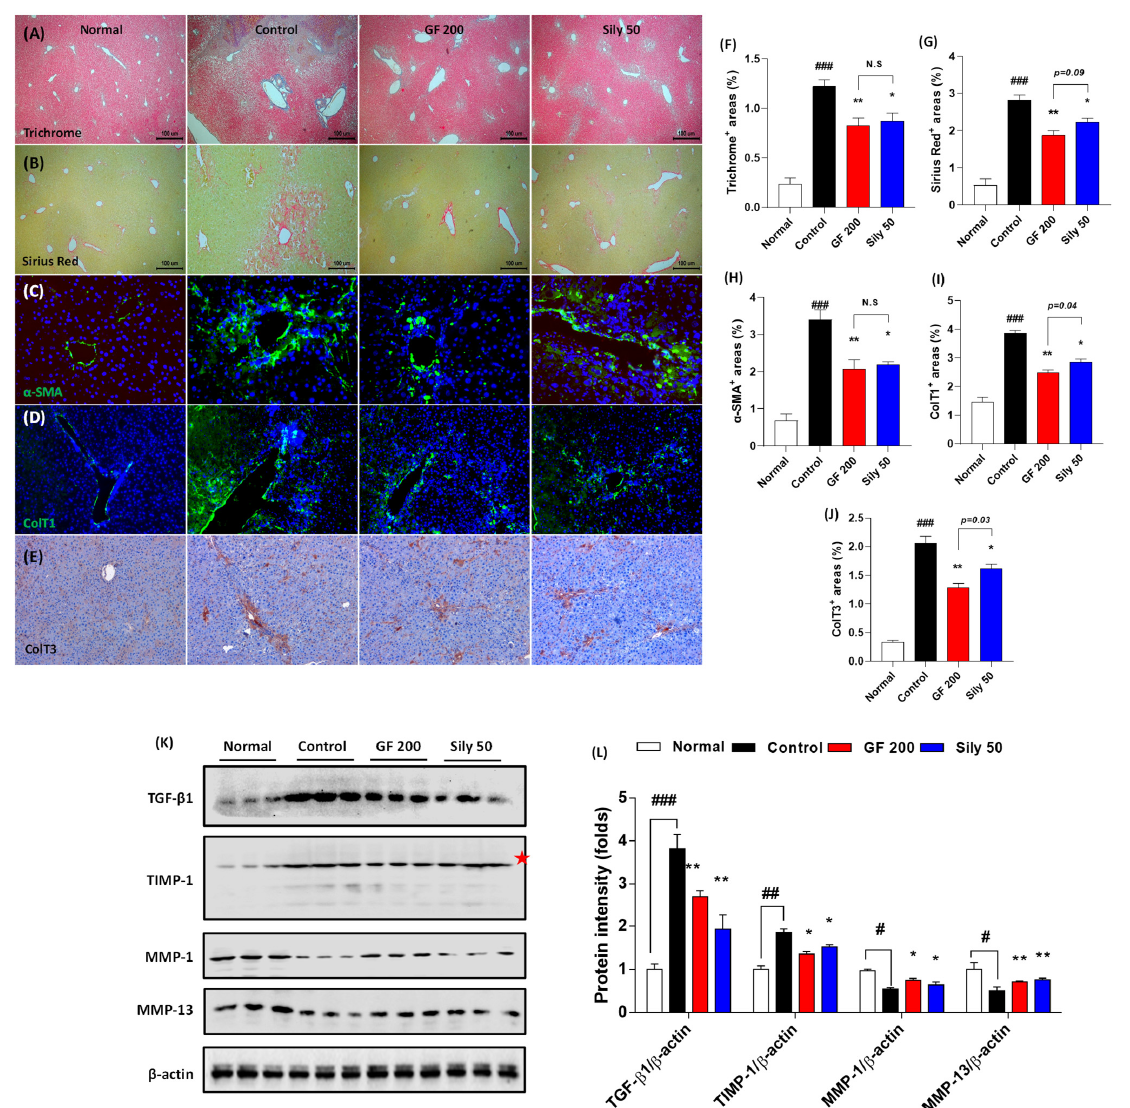
Figure 4. GF attenuates liver fibrosis by degradations of ECMs in tissue. ( A ) Masson’s trichrome staining, ( B ) Sirius Red staining, ( C ) IF analysis against α -SMA, ( D ) Collagen type 1, and ( E ) IHC against Collagen type 3. ( F – J ) Quantification analyses for Masson’s trichrome staining, Sirius Red staining, IF analysis against α -SMA, Collagen type 1, and IHC against Collagen type 3. ( K ) Western blot analysis of ECM proteins TGF- β 1, TIMP-1, MMP-1, and MMP-13 and ( L ) protein intensity. Data were expressed mean ± SEM ( n = 4 for each group in staining images; n = 3 for each group for Western blot analysis). N.S, not significant, # p < 0.05, ## p < 0.01, and ### p < 0.001 for Normal vs. Control; * p < 0.05 and ** p < 0.01 for Control vs. GF 200 or Sily 50. Masson’s trichrome, Sirius Red staining, and IHC against Collagen type 3 images were captured by light microscope condition (40-,100-, and 200- × magnifications). IF images were observed by fluorescence filtered equipped microscopy condition (200- ×